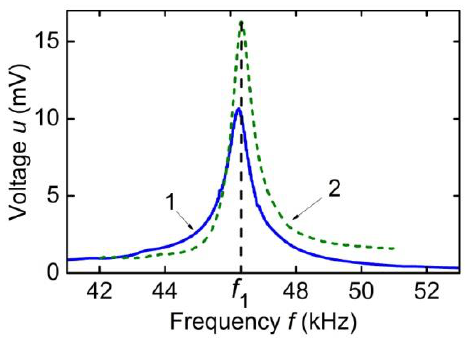
Figure 10. Dependence of ME voltage u on the frequency f upon excitation of a Metglas/PZT structure by a strip with a current (1) and by a volumetric coil (2) at H = 5 Oe.